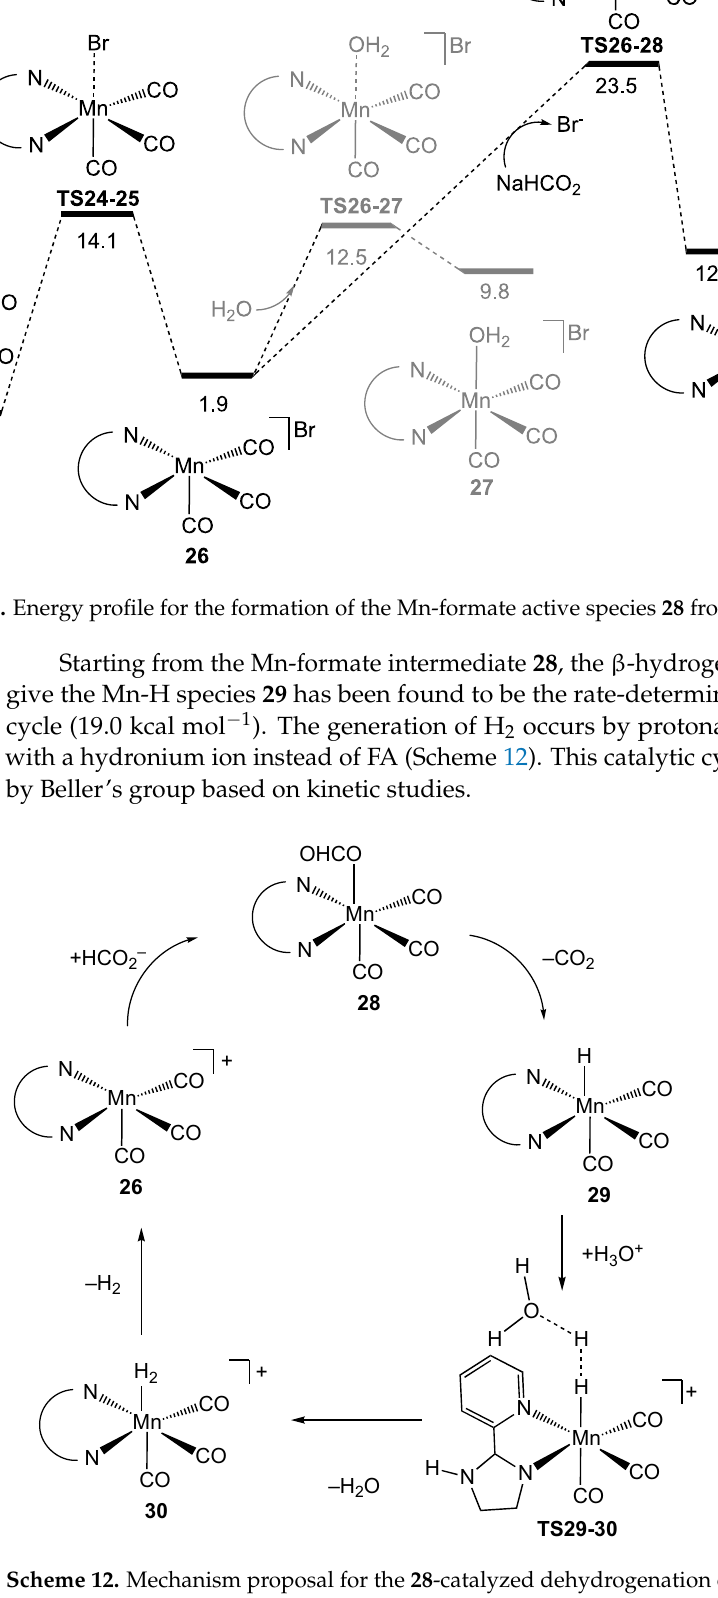
11 of 20 Figure 4. Examples of Mn(I)- κ 2 - N - N catalyst precursors.